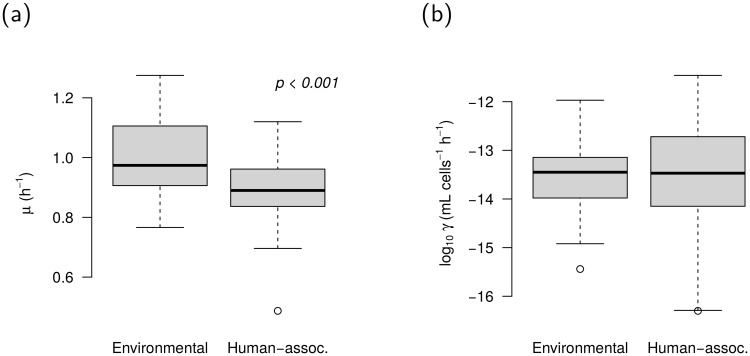
Characteristics of E. coli strains isolated from river sediments and human-borne raw sewage.a: Intrinsic growth rate constants. The p-value indicates a significant shift in location (U test). b: Bulk conjugation rate constants. All data refer to the case without antibiotic exposure. Boxes depict interquartile ranges, whiskers extend to the most extreme data points not being classified as outliers according to the conventional 1.5 × IQR rule. Outliers are displayed as dots.